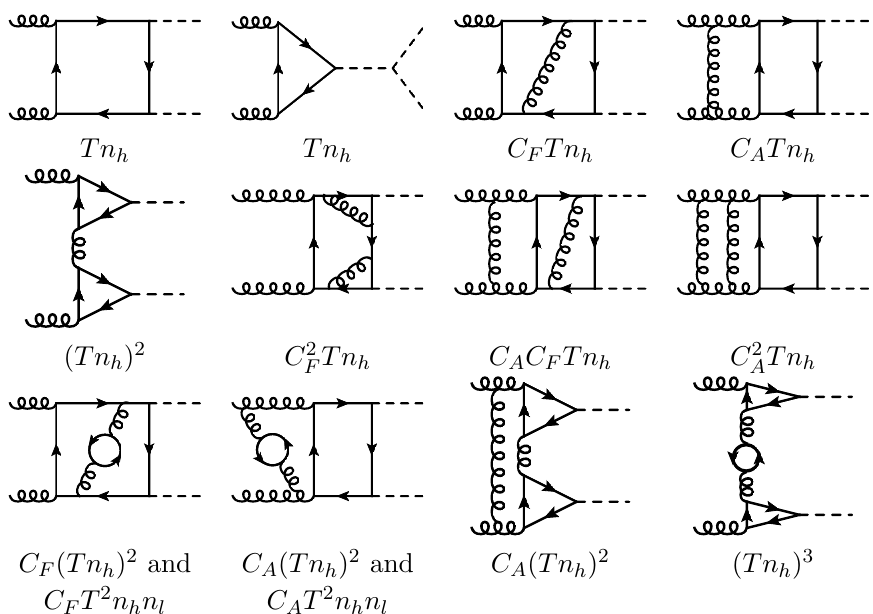
Figure 1 . Sample Feynman diagrams contributing to gg ! HH . For simplicity we show diagrams with a triple-Higgs boson coupling only at one-loop order. A sample colour factor is shown below each diagram. However, note that in general a diagram contributes to more than one colour structure. Solid, dashed and curly lines denote quarks, Higgs bosons and gluons